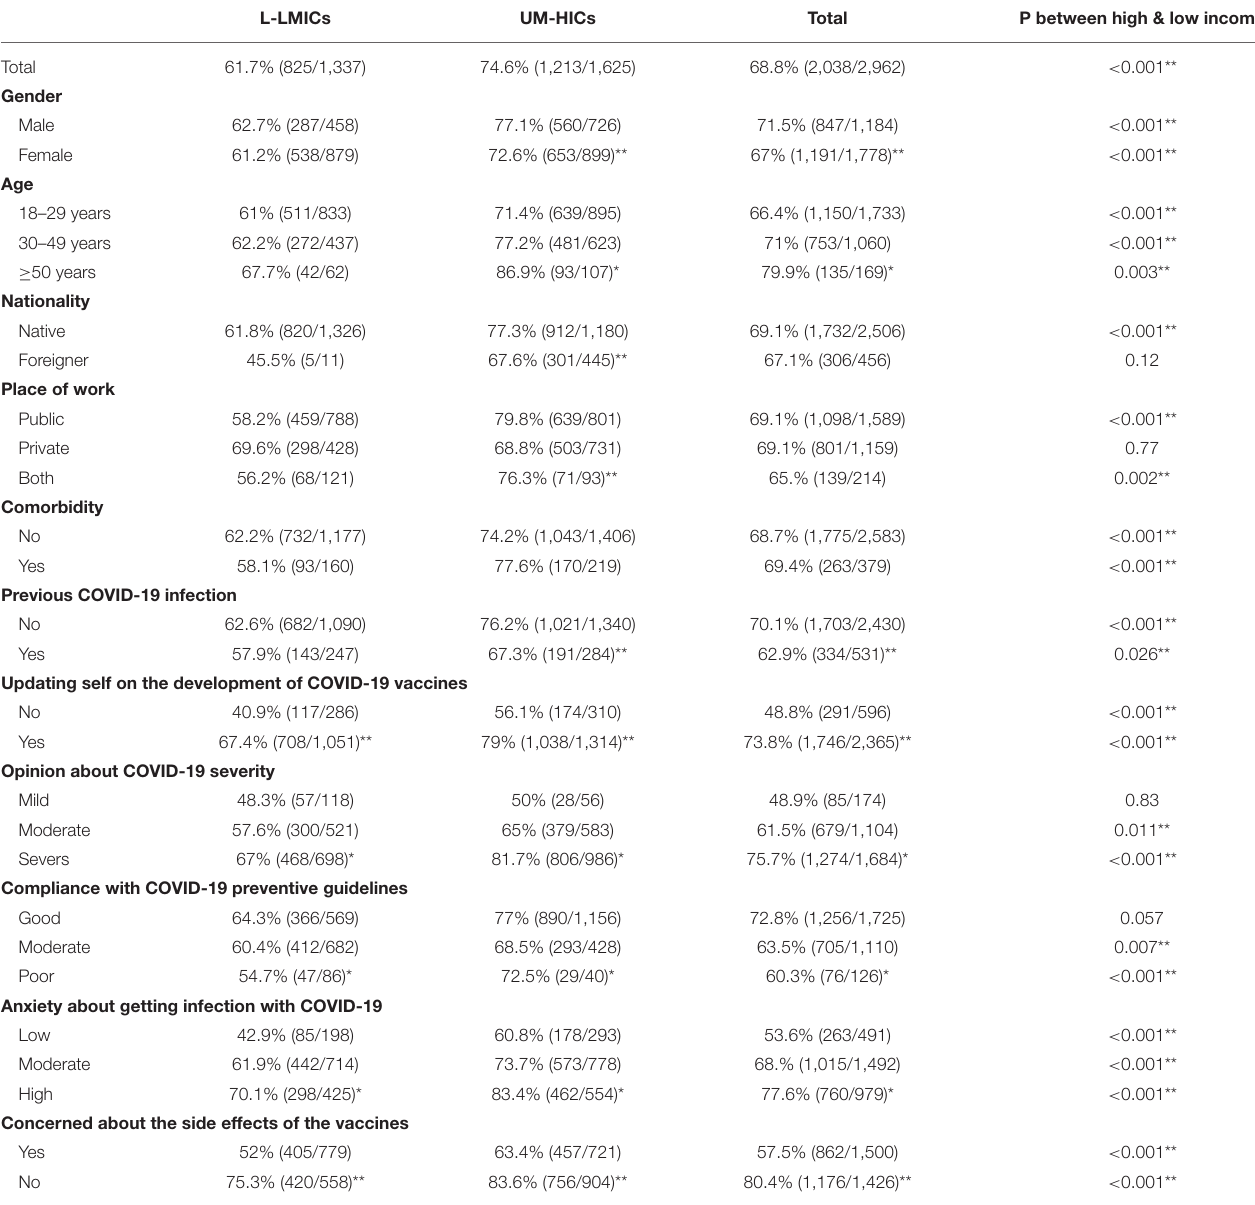
TABLE 5 | Agreement among HCWs in L-LMICs and UM-HICs to accept a COVID-19